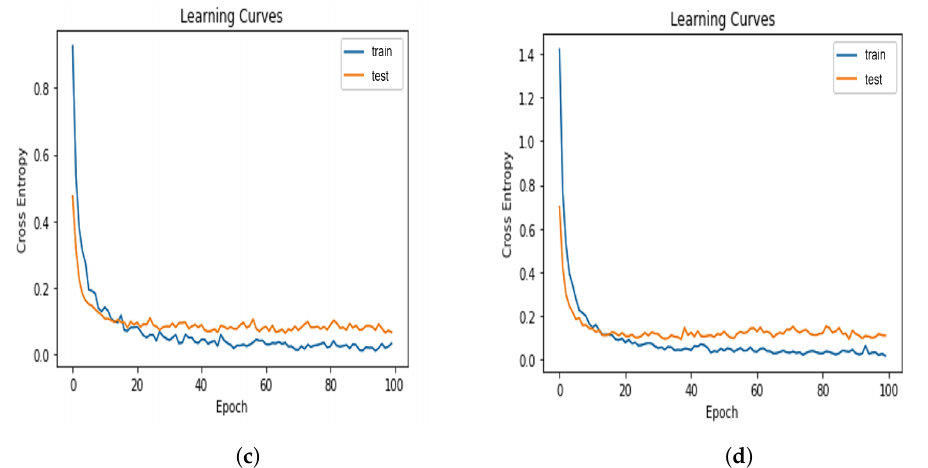
Figure 7. Training and testing curves of DNN model for different aphasia classifications and different input audio lengths whose features have been extracted using MFCC. ( a ) Training and testing curves of DNN model for aphasia category classification using 20 s audio chunks. ( b ) Training and testing curves of DNN model for aphasia severity level classification using 20 s audio chunks. ( c ) Training and testing curves of DNN model for aphasia category classification using 10 s audio chunks. ( d ) Training and testing curves of DNN model for aphasia severity level classification using 10 s audio chunks.